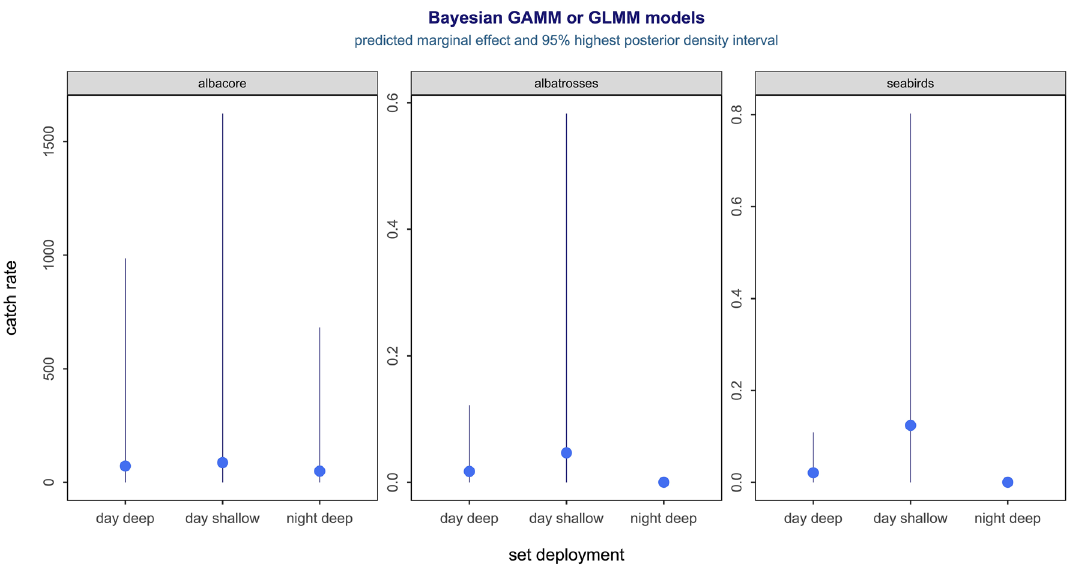
Figure 1. Predicted 3-category set deployment treatment effect for albacore catch per set (left), probability of catching at least 1 albatross per set (middle), and probability of catching at least 1 seabird per set (right). The albatross night-deep 95% highest posterior density interval (HDI, 0 to 0.0003) and seabird night-deep 95% HDI (0 to 0.0004) are concealed by the solid dot. Solid dot = median predicted marginal effect. Vertical bar = 95%